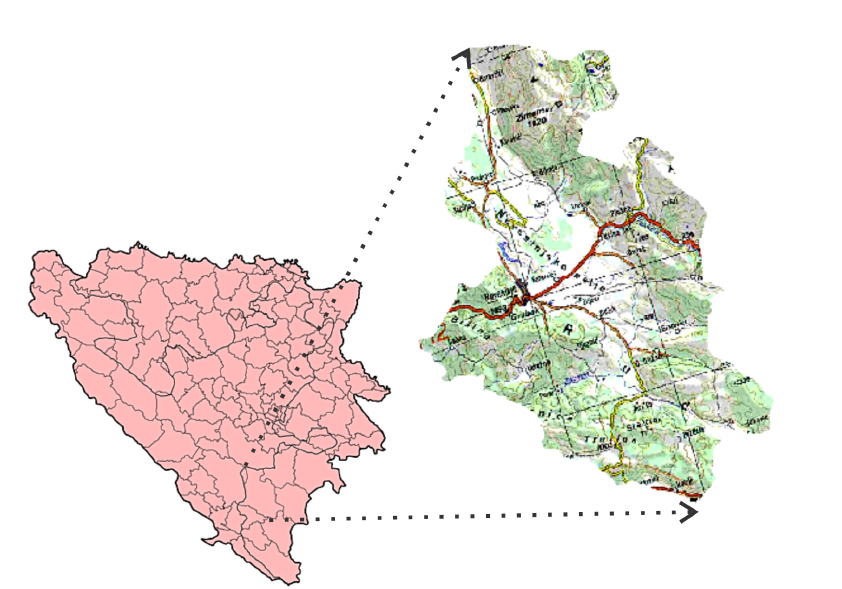
Figure 1 – Geographical location of the Municipality of Nevesinje in RS Рис . 1 – Географическое положение Муниципалитета Невесинье , Республика Сербская Slika 1 – Geografski položaj opštine Nevesinje, Republika